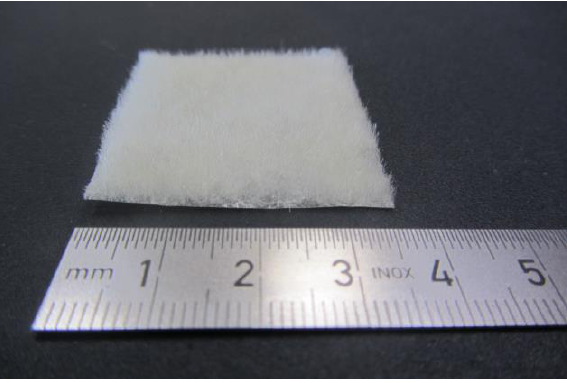
Figure 10. Chitosan fiber scaffold with vertically aligned chitosan fibers [206].